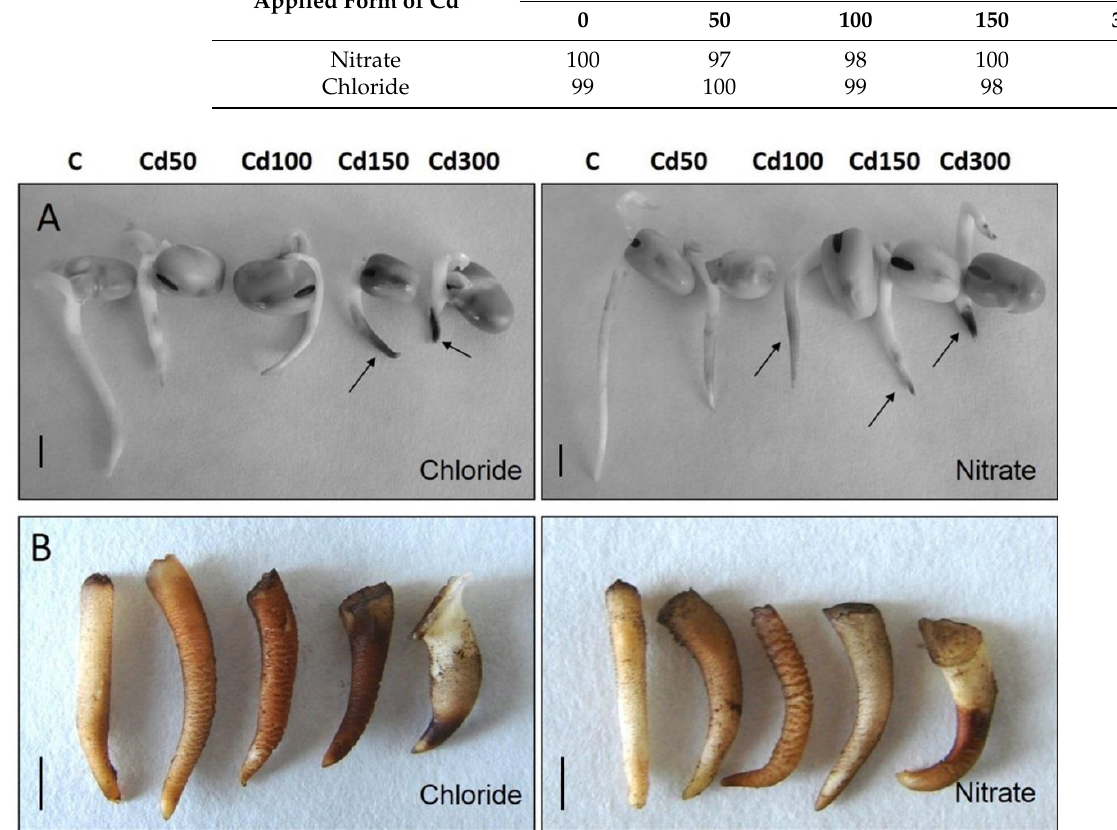
Figure 1. Effects of different doses of cadmium (Cd) (mg/L) on the growth ( A ) and oxidative damage ( B ) of roots of fava bean. Arrows indicate the blackening areas of the plant tissue. Brown color shows H 2 O 2 accumulation. C—Control, Scale bar = 1 cm.